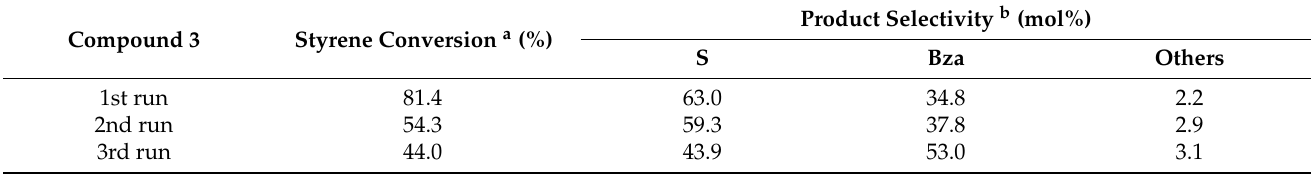
Table 3. Recyclability and reusability of compound 3